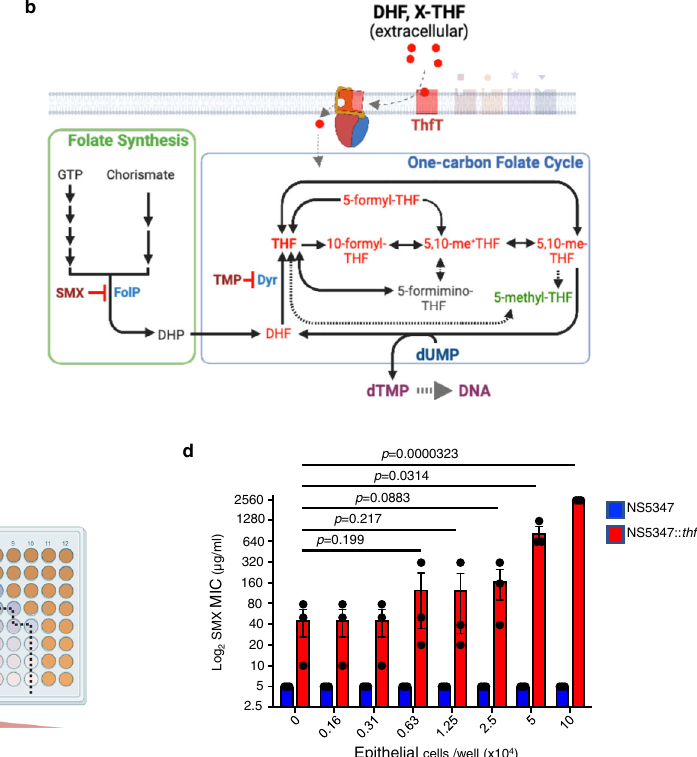
enzyme 43 (Supplementary Fig. 8). Created with BioRender.com. GTP guanosine triphosphate, DHP dihydropteroate, DHF dihydrofolate, dUMP deoxyuridine monophosphate, dTMP deoxythymidine monophosphate, 5,10-me-THF 5,10- methylene-THF. c Cartoon schematic of experiment to test uptake of cellular folates by ThfT. SMX MICs were by broth microdilution across a 2-fold serial dilu- tionofSMX(2500to5 μ g/ml,lefttoright)inthepresenceofa2-foldserialdilution of epithelial cell lysates (1×10 5 to 1.6×10 3 cells/well, top to bottom). After over- night incubation, MIC values were determined by examining GAS growth (orange wells)foreach epithelialcelllysate concentration. d Ability of epithelialcelllysates to confer ThfT-mediated SMX resistance using procedure in c . Data from three biological replicates are presented as mean values ± SEM. Differences assessed using a one-tailed, paired Student ’ s t -test. Source data for panels a and d are pro- vided as a Source Data fi